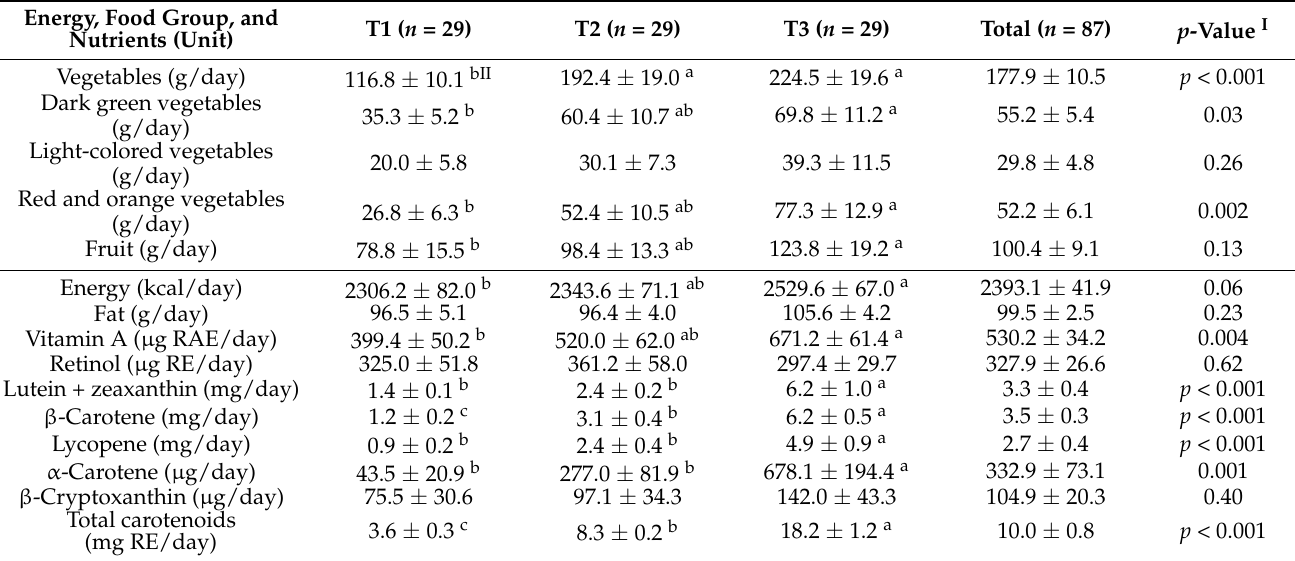
Table 2. Energy intake, intakes of fruit and vegetables, and selected nutrients of the 87 Hong Kong lactating